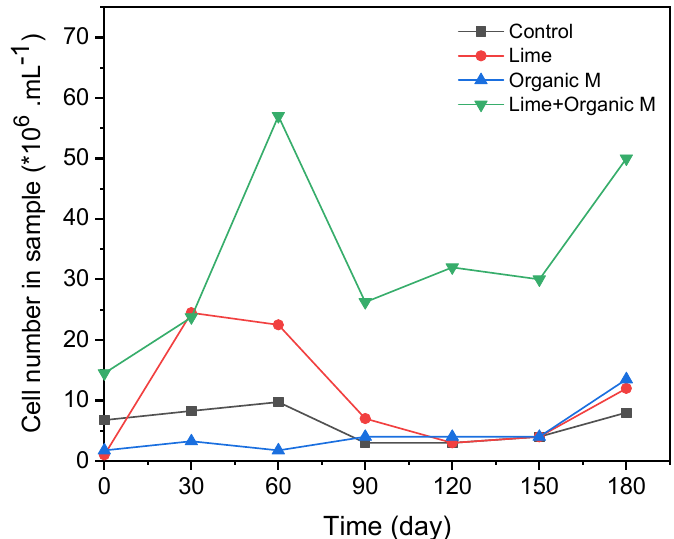
Figure 4. Cell number in the solution phase of the four columns (control, Lime, OM, and Lime + OM) during the incubation.